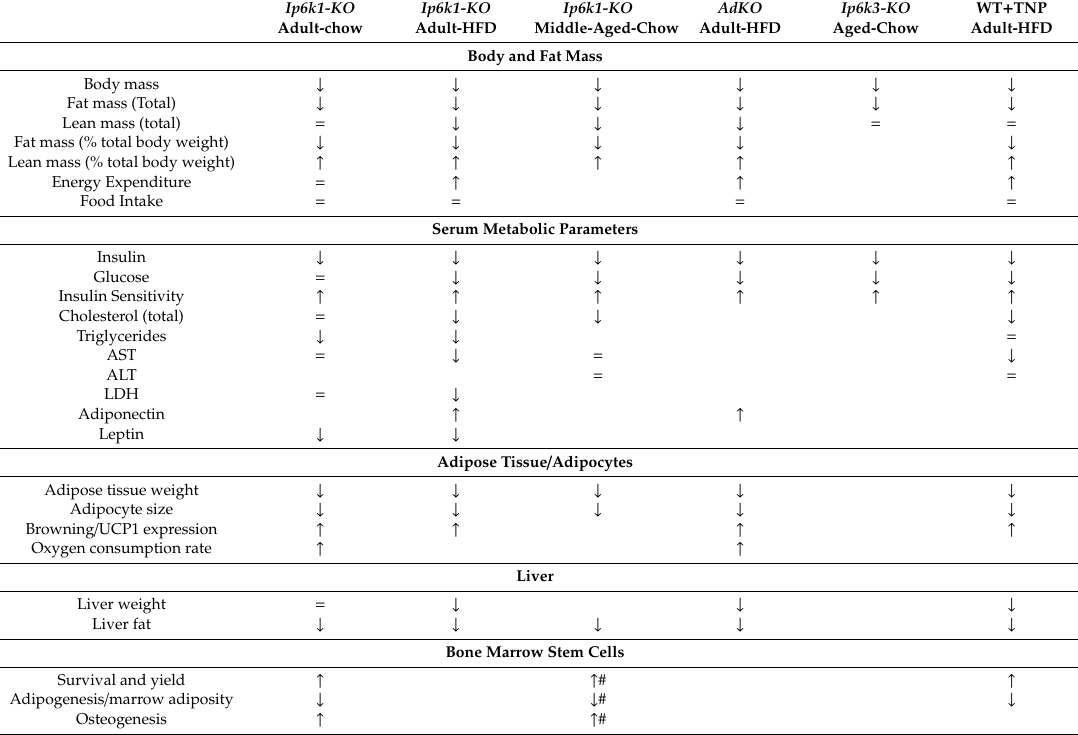
Table 1. Summary of the metabolic parameters of Ip6k1-KO [22,30,41], AdKO [29], Ip6k3-KO [34] and TNP-treated WT [42] mouse models in ambient temperature conditions. Symbols ↑ , ↓ and = denote increase, decrease and no change, respectively. # indicates that the study was done in 18-month old Ip6k1-KO mice instead of middle-aged (10-month) mice. Blank denotes that the parameter was not measured. Parameters that were measured in only one model are not included. For Ip6k1 -KO [40] and AdKO [29] mice, some parameters were assessed in thermoneutral conditions, which are not